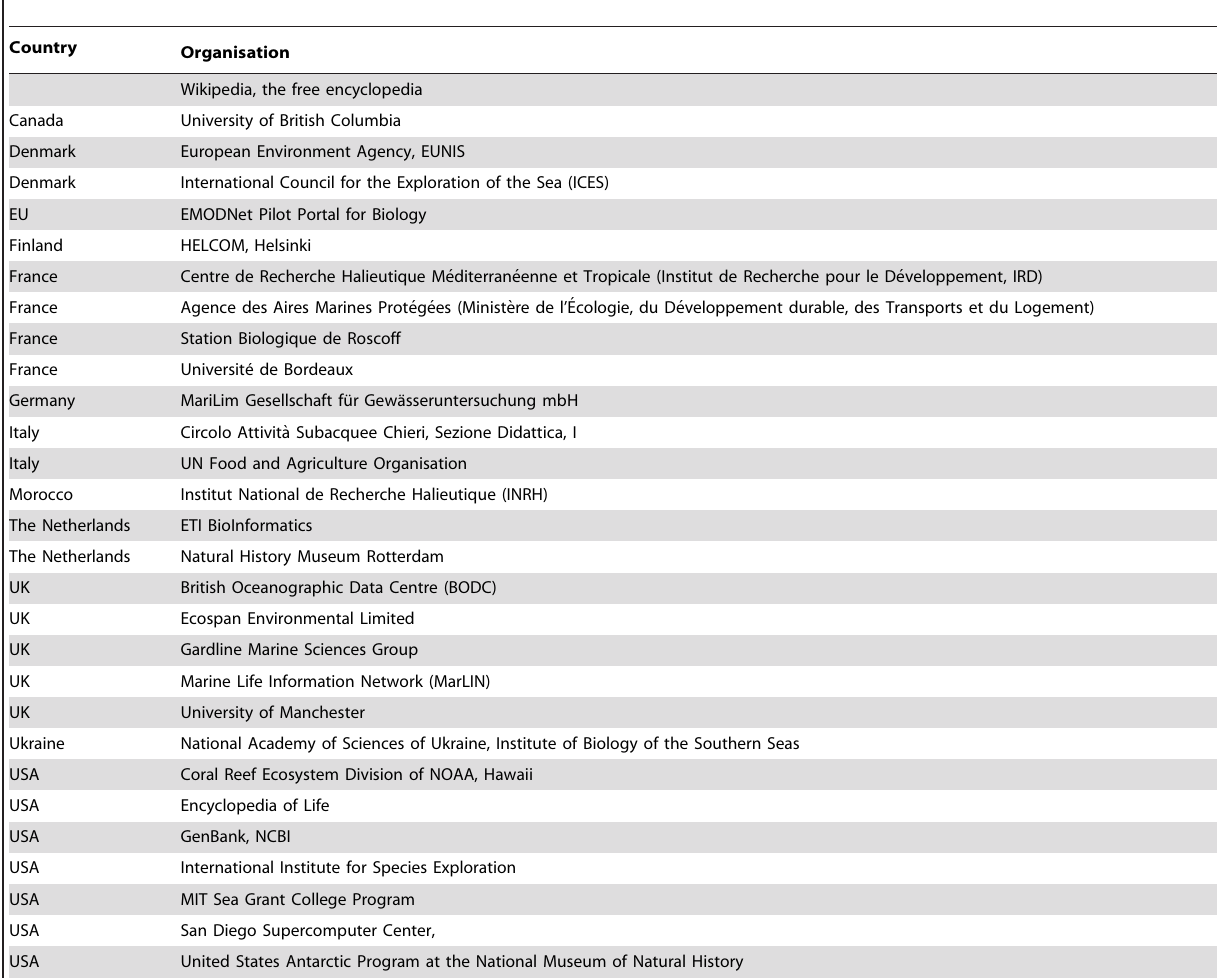
Table 8. Some of the organisations using the WoRMS web service for their data management systems and/or research.